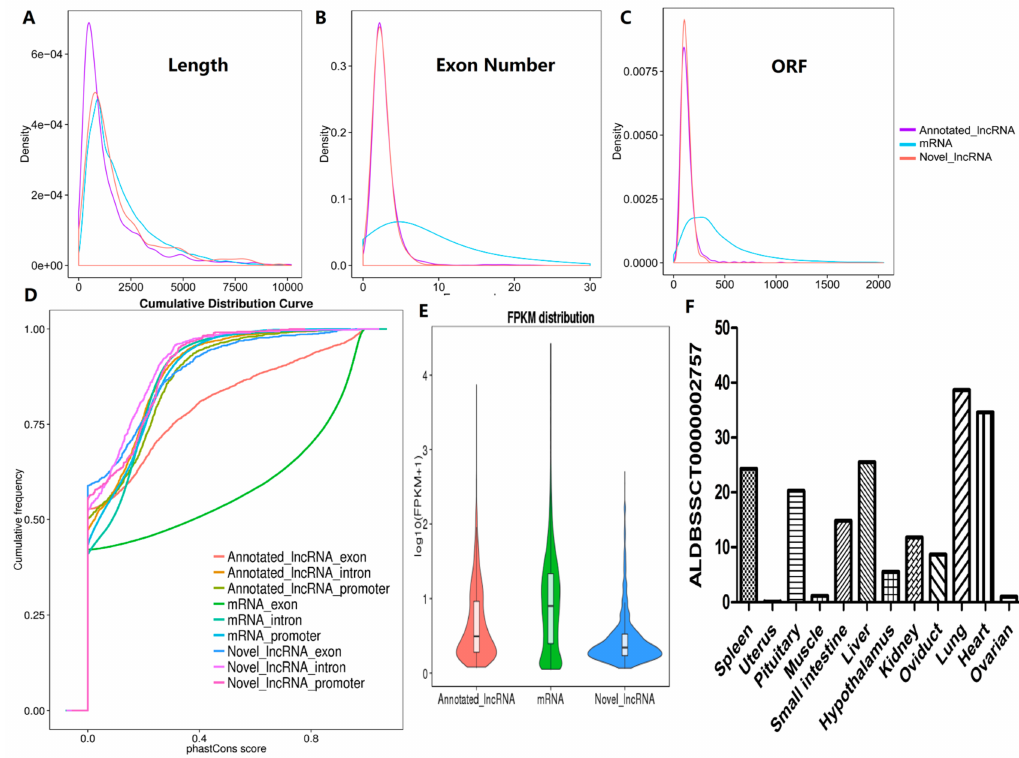
Figure 2. Comparison of candidate lncRNAs and mRNAs characteristics. ( A ) Length, ( B ) exon